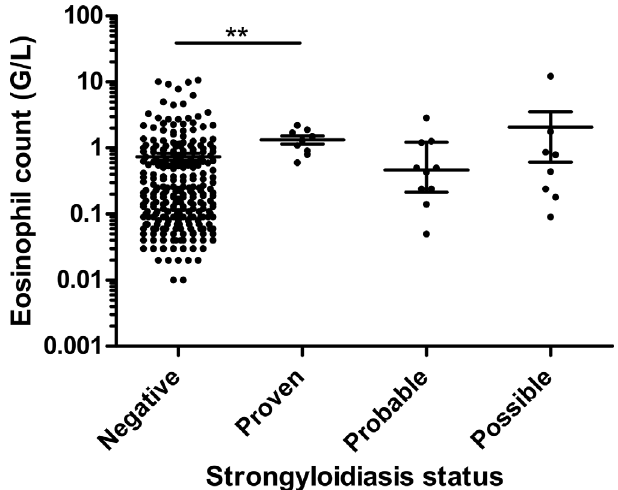
Figure 2. Eosinophil counts related to patient status. Median and interquartile range, ** p <